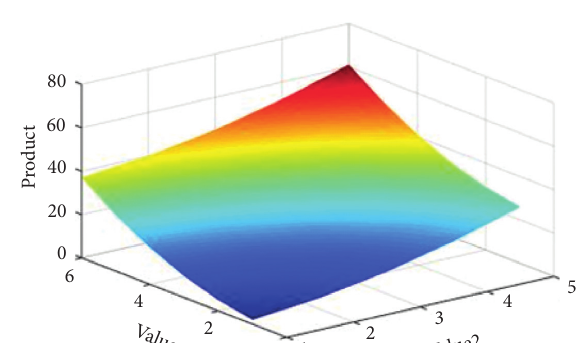
Figure 6: Error curve.